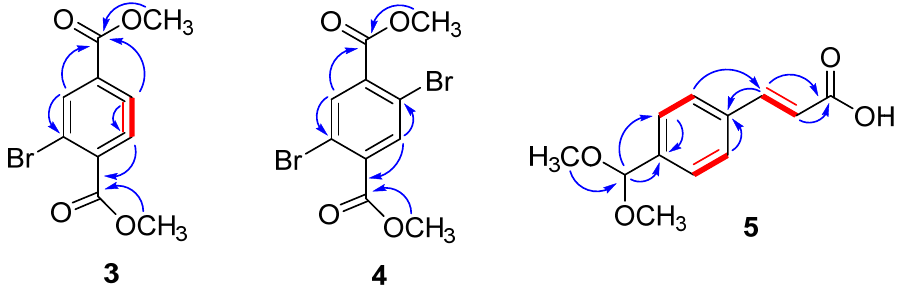
Figure 3. Key H → C HMBC and H ꟷ H COSY correlations of compounds 3 , 4, and 5.